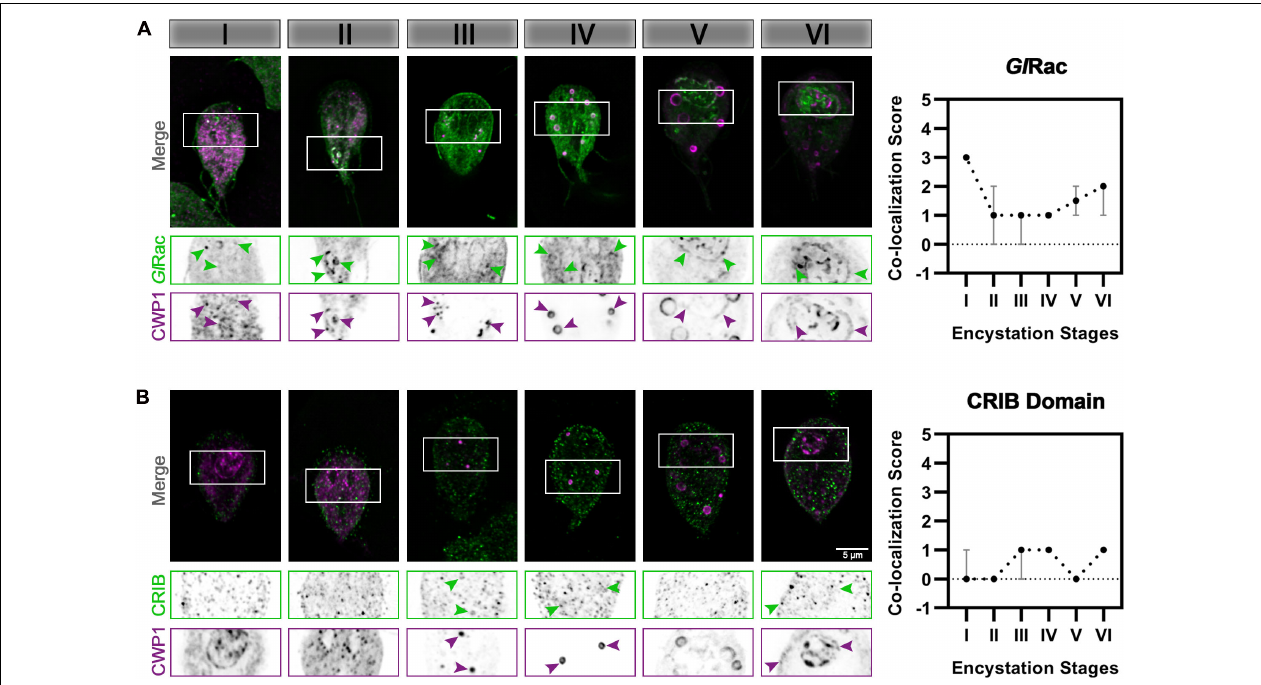
FIGURE 3 | Gl Rac activity during encystation is stage-specific. Cells expressing (A) HALO- Gl Rac (endogenous tag) or (B) CRIB-HA-mNG (exogenous expression) were subjected to the two-step encystation process. They were then harvested at 8 and 24 h p.i.e. to be fixed and stained for HALO- Gl Rac or CRIB-HA-mNG and CWP1. 15–20 cells per encystation stage were then imaged to visualize HALO- Gl Rac (green) or CRIB-HA-mNG (green) and CWP1 (magenta) and scored for the level of colocalization between HALO- Gl Rac or CRIB-HA-mNG and CWP1 stained structures. Plot shows median scores with 95% confidence interval. Arrowheads indicate HALO- Gl Rac or CRIB-HA-mNG colocalizing with CWP1-stained